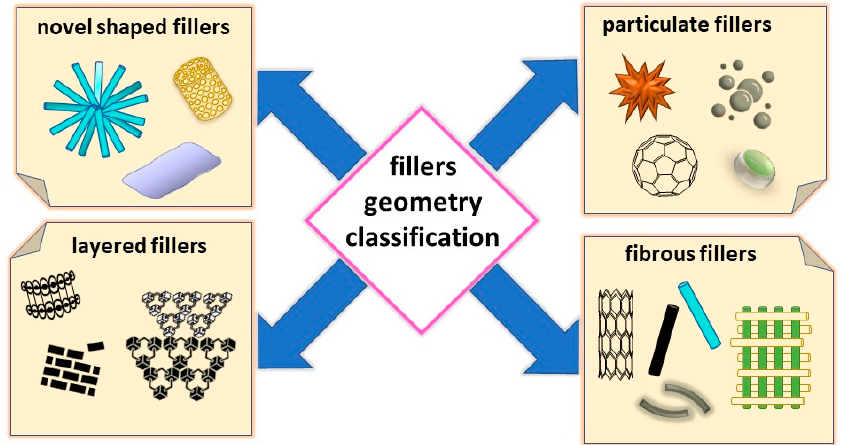
Figure 3. Different shapes of the filler applied in polymer composite design and fabrication.